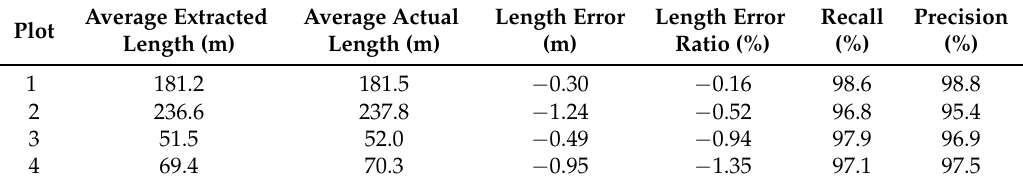
Table 7. Accuracy assessment of ridge